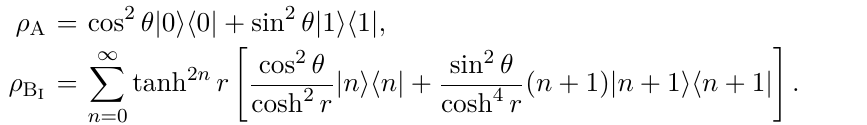
Figure 5 . Quantum coherence C l r for different θ